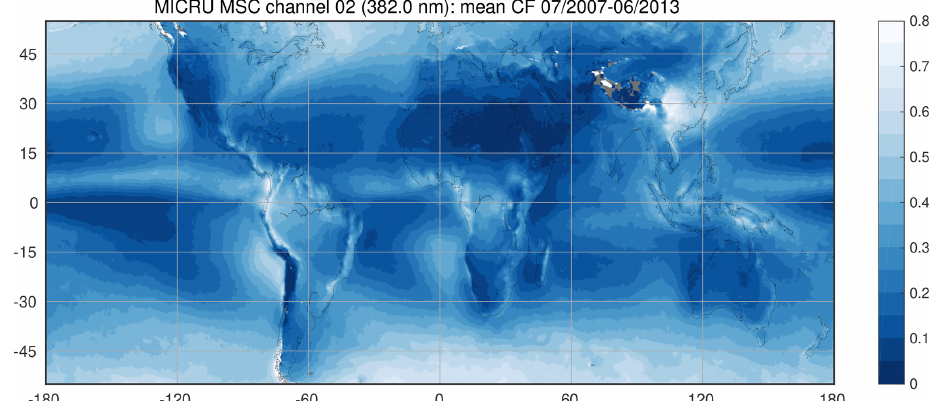
Figure F1. The 6-year average of MICRU MSC channel 2 cloud fraction measurements recorded between 1 July 2007 and 30 June 2013. Areas without data are plotted in gray.